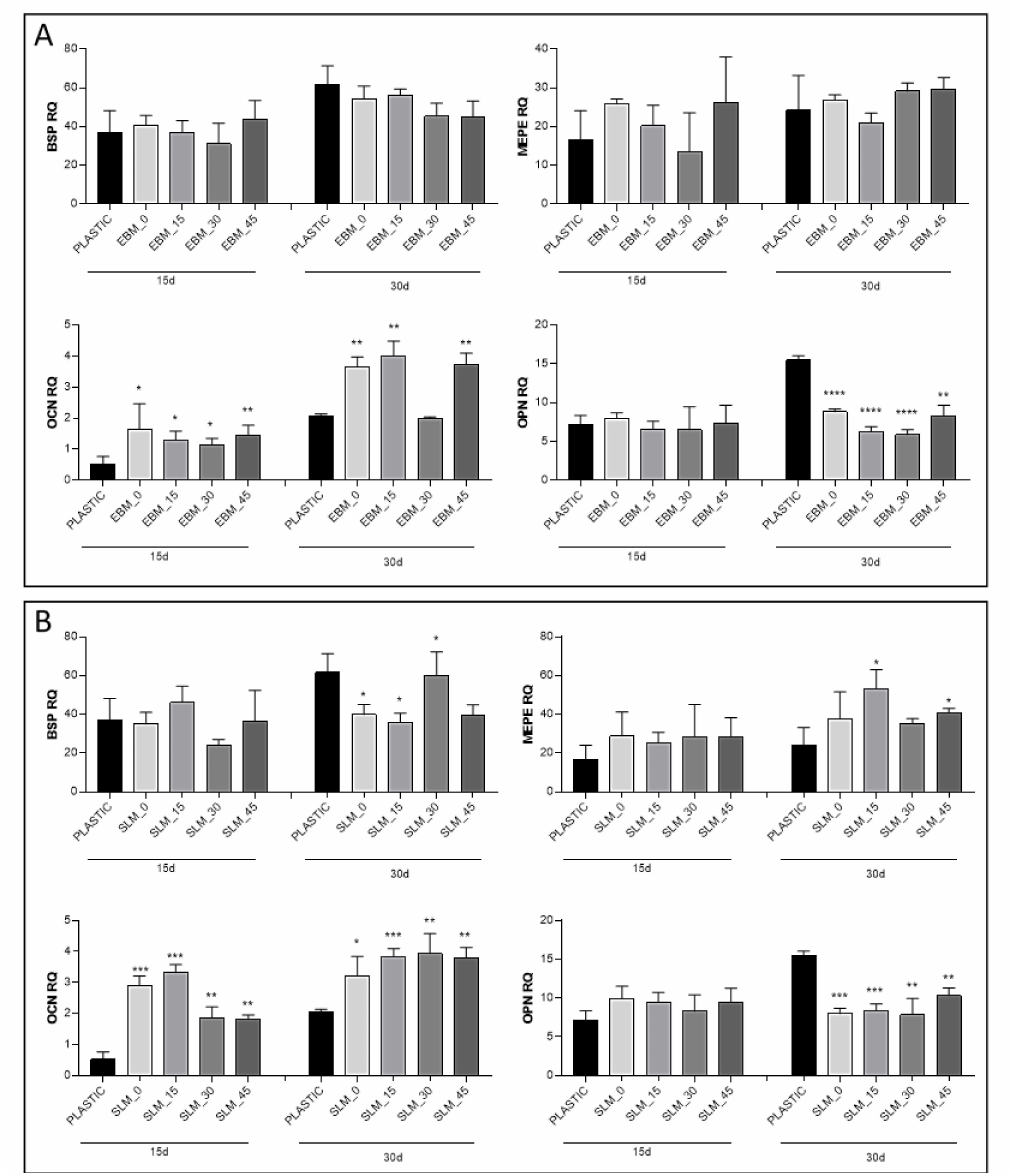
Figure 9. Osteogenic gene expressions of MC3T3-E1 cells cultured in mineralization medium after 15 and 30 days on EBM ( A ) and SLM ( B ) titanium sca ff olds. The graph shows the relative quantification (RQ) of Bsp, Mepe, Ocn , and Opn genes normalized with Gapdh and calculated using as calibrator (RQ calibrator = 1) the constitutive gene expression of MC3T3-E1 cultured in basal medium. Error bars represent SD based on triplicates derived from three di ff erent experiments ( n = 3). Significant di ff erences were analyzed using t -test. A value of p < 0.05 was considered statistically significant. (* p < 0.05, ** p < 0.01, *** p < 0.001, **** p <